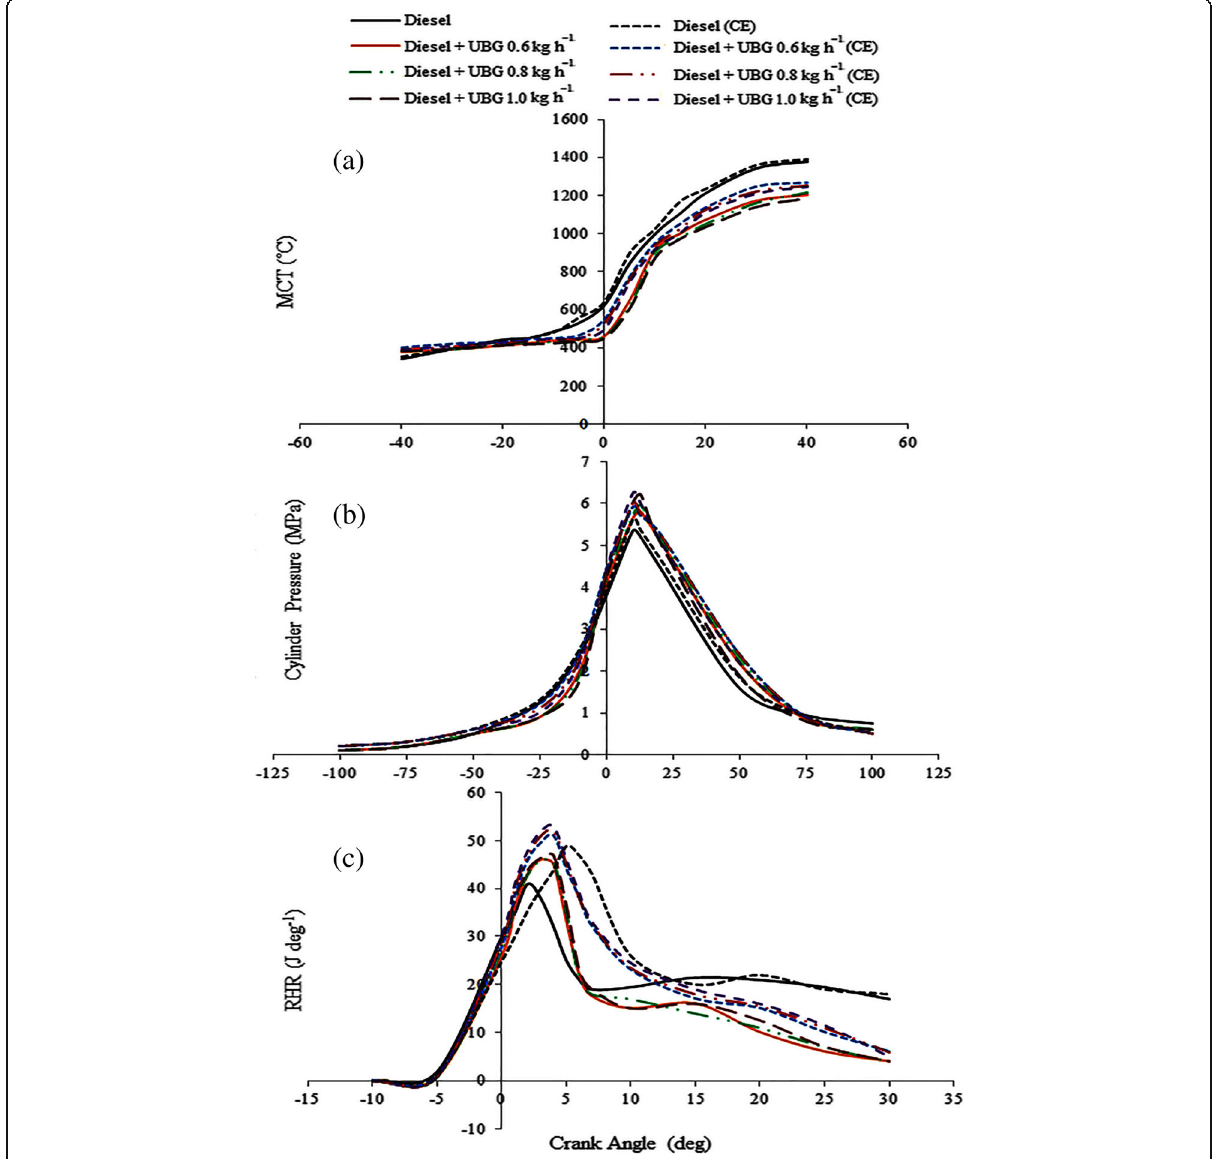
Fig. 3 Change in combustion parameters with engine load ( a ) MCT, ( b ) Cylinder pressure, ( c )